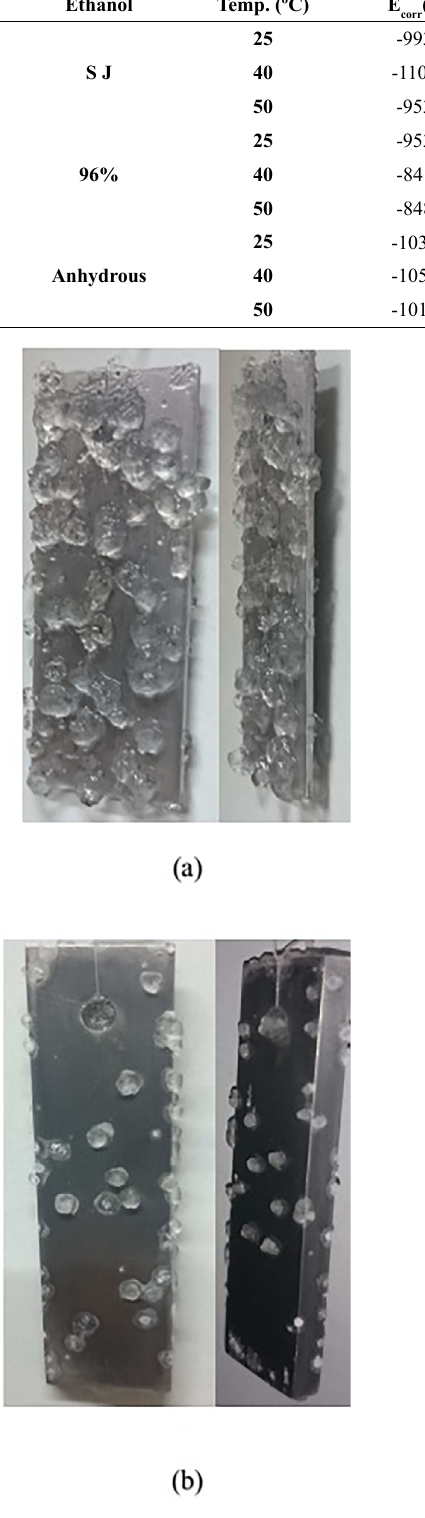
Table 4. Electrochemical parameters obtained through extrapolation of Tafel for alloy Al 1050. Alloy Ethanol